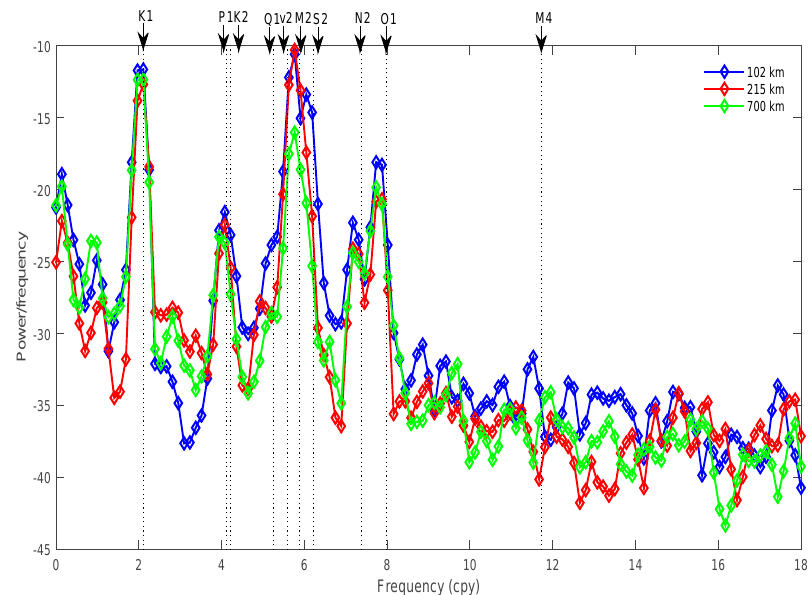
Figure 7. PSD of observed SLA along TOPEX-Jason ground track 86. Points are located at 158°48 ′ 13.00 ″ E, 9°58 ′ 4.80 ″ S (blue curve), 162°18 ′ 57.26 ″ E, 19°2 ′ 42.96 ″ S (red curve), and 160°39 ′ 22.68 ″ E, 14°50 ′ 44.88 ″ S (green curve) around 102 km, 215 km, and 700 km, respectively, from the coast. The aliasing period of the eight main tidal constituents (e.g., M 2 ) and major shallow-water tidal constituent (M 4 ) are shown by arrows.